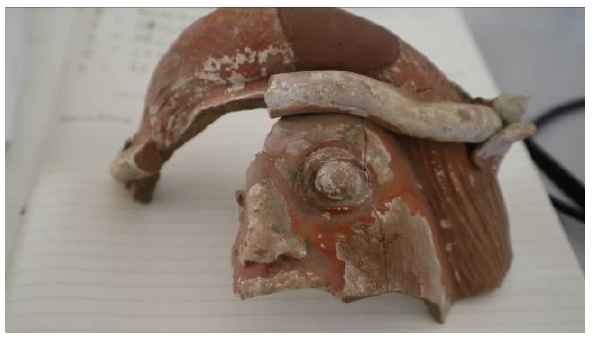
Figure 3. Dressel Amphorae